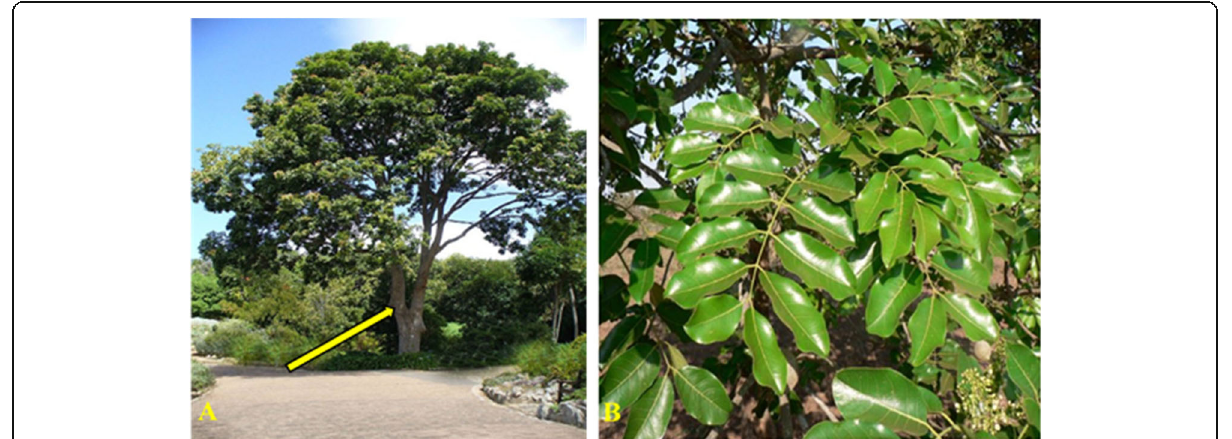
Fig. 2 K . anthotheca . a Tree. b Leaves. Source: Google images